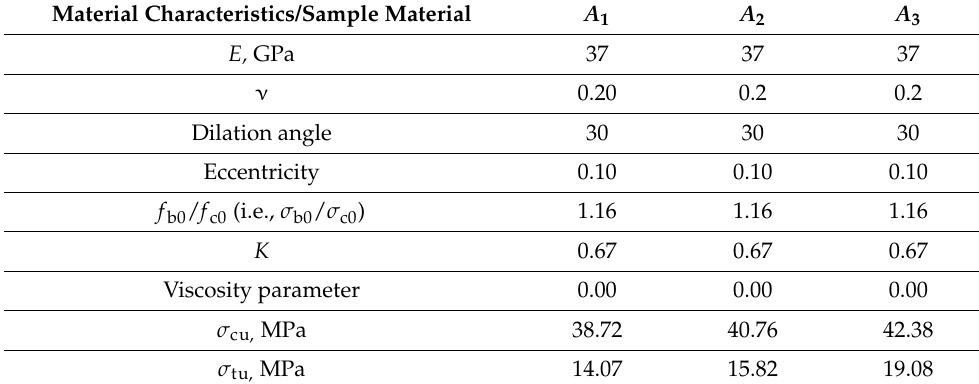
Table 3. Details of the CDP material model used in the numerical model.